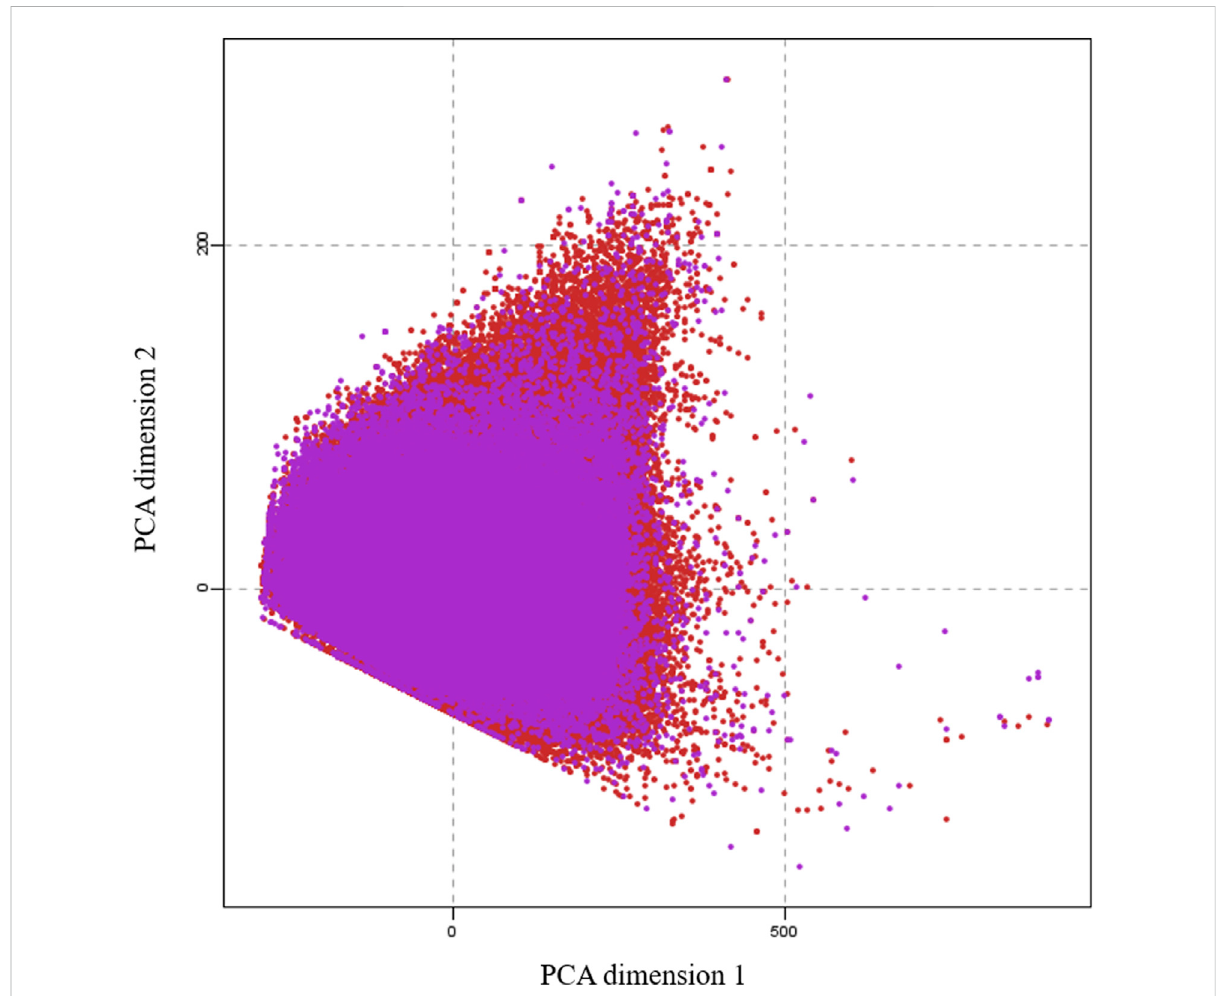
FIGURE 1 A principal component analysis (PCA) plot, showing the comparison of the chemical space de fi ned by our dataset (purple) and the chemical space represented by CHEMBL25 databases